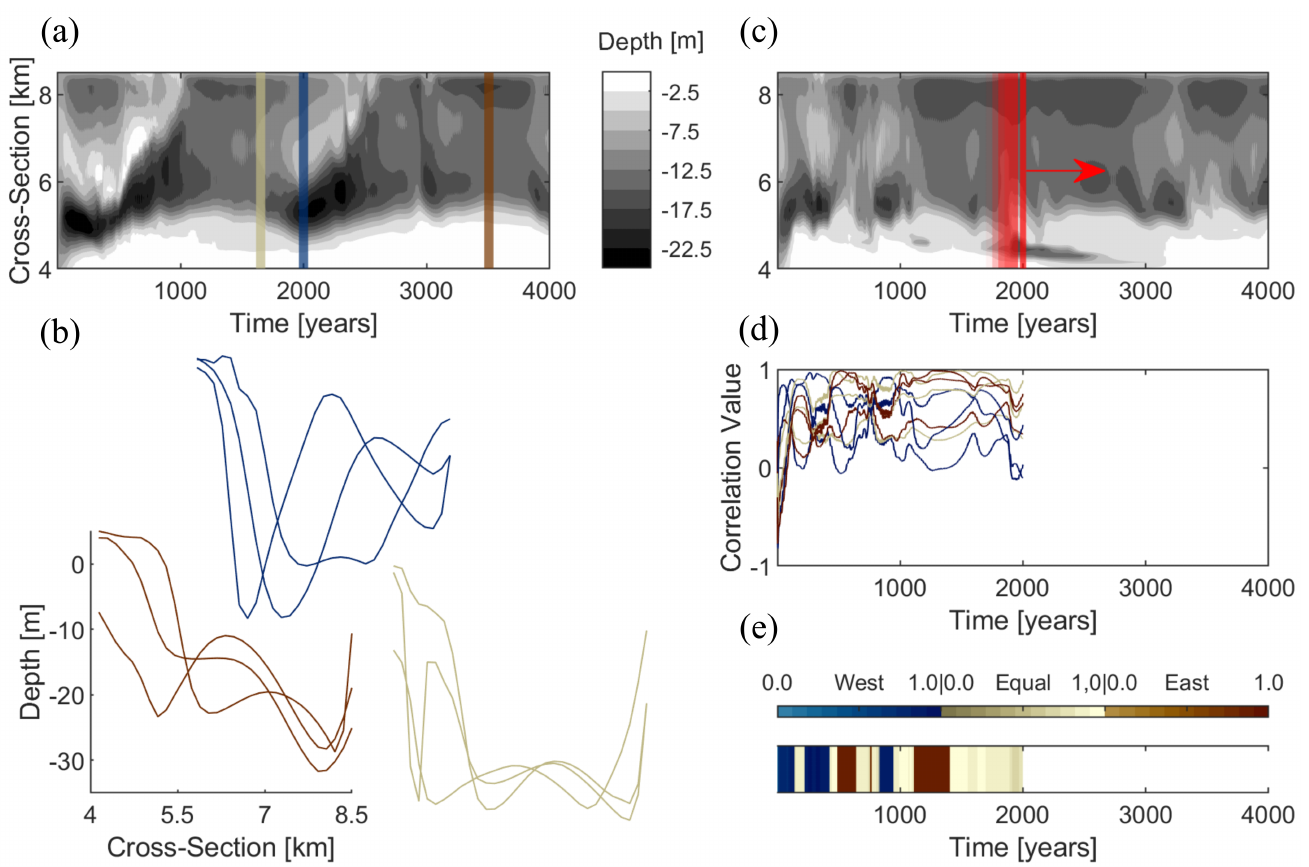
Figure 4. Graphical description of the CASE method with ( a ) the selection of representative cases, ( b ) the final nine cases for this study, ( c ) the correlation analysis over time, ( d ) the resulting correlation values and ( e ) the final result, where the morphological state is presented over time with the corresponding case (color) and its correlation value (color